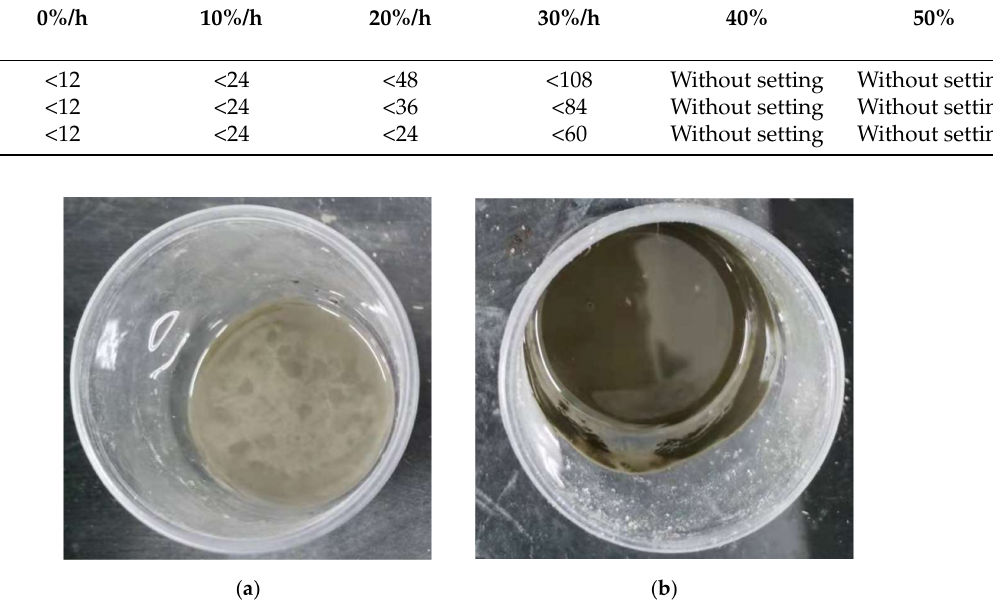
Figure 2. ( a ) Cement paste (water ratio 0.4) with 50% PEG-600; ( b ) cement paste (water ratio 0.3) with 50%